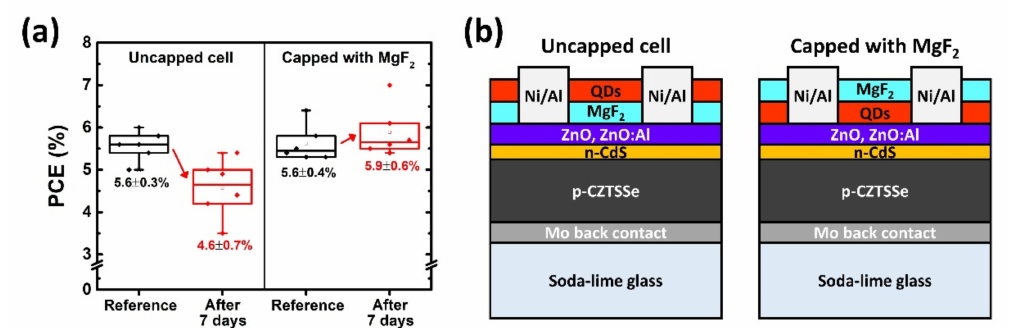
Figure 6. ( a ) Statistical box plots of the power conversion efficiencies (PCEs) and ( b ) schematic structure of the uncapped and capped CZTSSe solar cells. The uncapped and capped samples are prepared using the QD/MgF 2 /[CZTSSe cell] and MgF 2 /QD/[CZTSSe cell] structures, respectively. After deposition of the LDS layer, the samples were maintained for seven days in air at room temperature. The data are presented as mean ± standard deviation (n =